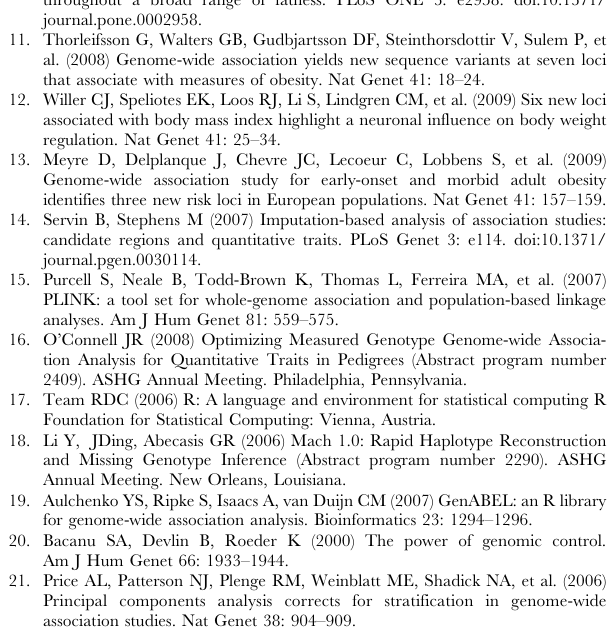
Table S2 GIANT Study-specific results for rs10146997. Found at: doi:10.1371/journal.pgen.1000539.s007 (0.06 MB Table S3 Comprehensive results from the CHARGE consor- tium for Waist Circumference with P , 9.9 6 10 2 6 .